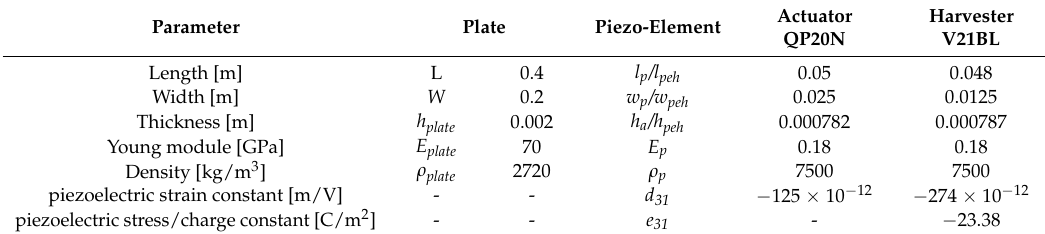
Figure 1. The rectangular aluminum plate with a piezo ‐ harvester PEH and piezo ‐ actuators PA_1 and PA_2 integrated on the top surface of this structure. Table 1. Parameters of the host structure and piezo ‐ elements.